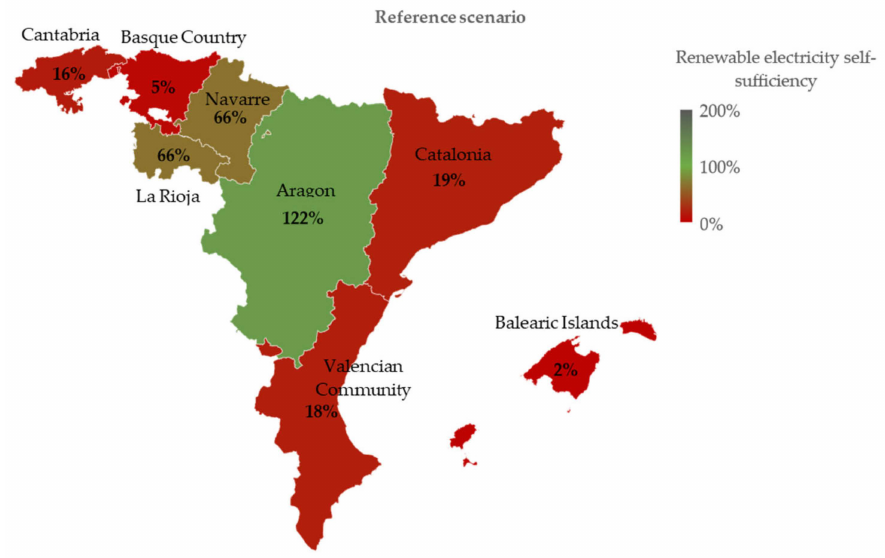
Figure 6. Renewable electricity self-sufficiency in the reference